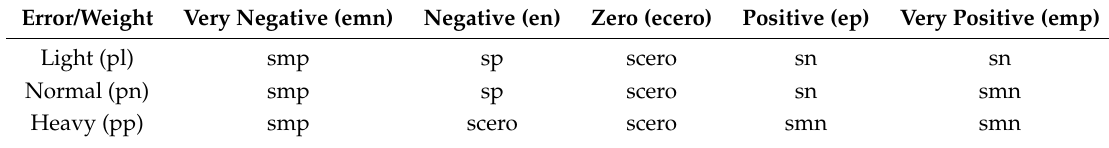
Table 6. Rules for the inference